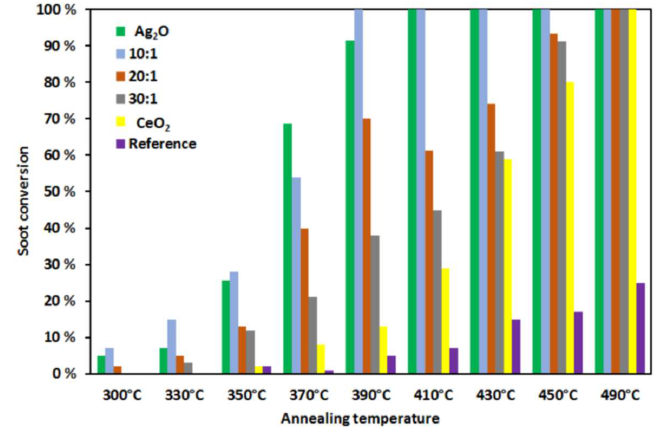
Figure 12. Conversion of oxidized soot on silver oxide, cerium oxide, and silver doped cerium oxide in ratio CeO 2 :Ag 10:1, 20:1, 30:1 thin films deposited on stainless steel foil at 200 ◦ C vs. annealing temperature over 2 h. The measurement uncertainty is approximately